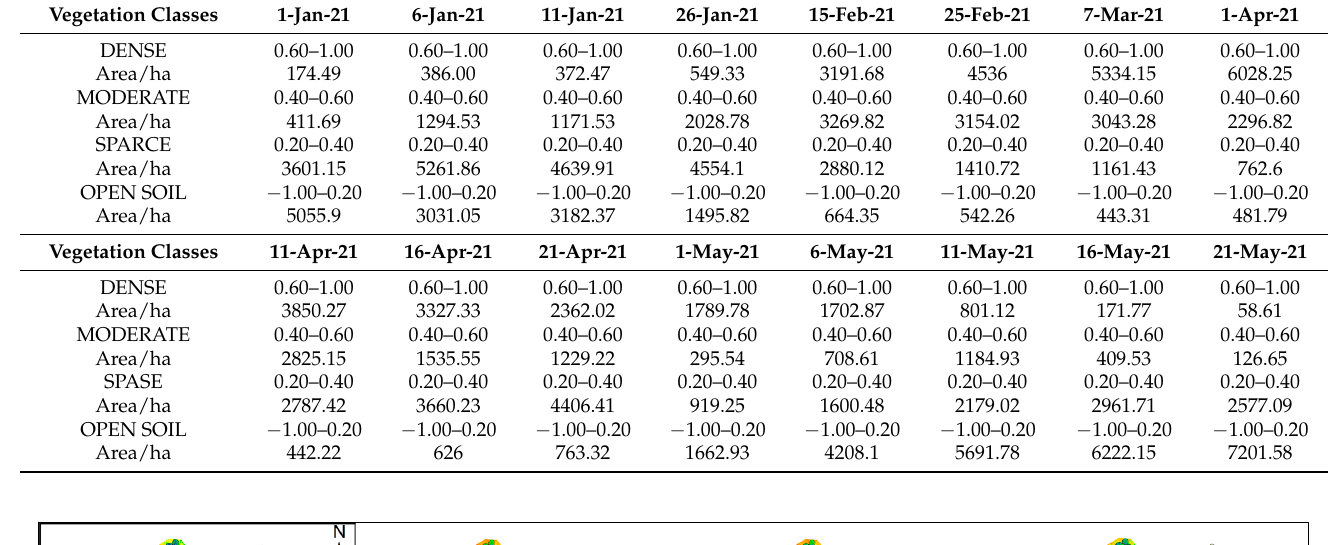
Table 1. Statistical indices of measured NDVI value, classes density, and area of each class.